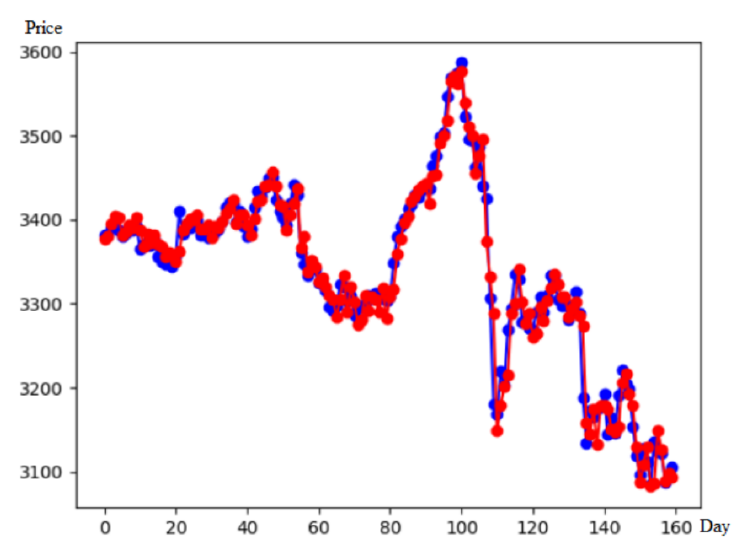
Fig. 10 A prediction sample of the proposed model (NN1:GRU,NN2:GRU, DATA SET: 000001.SH).